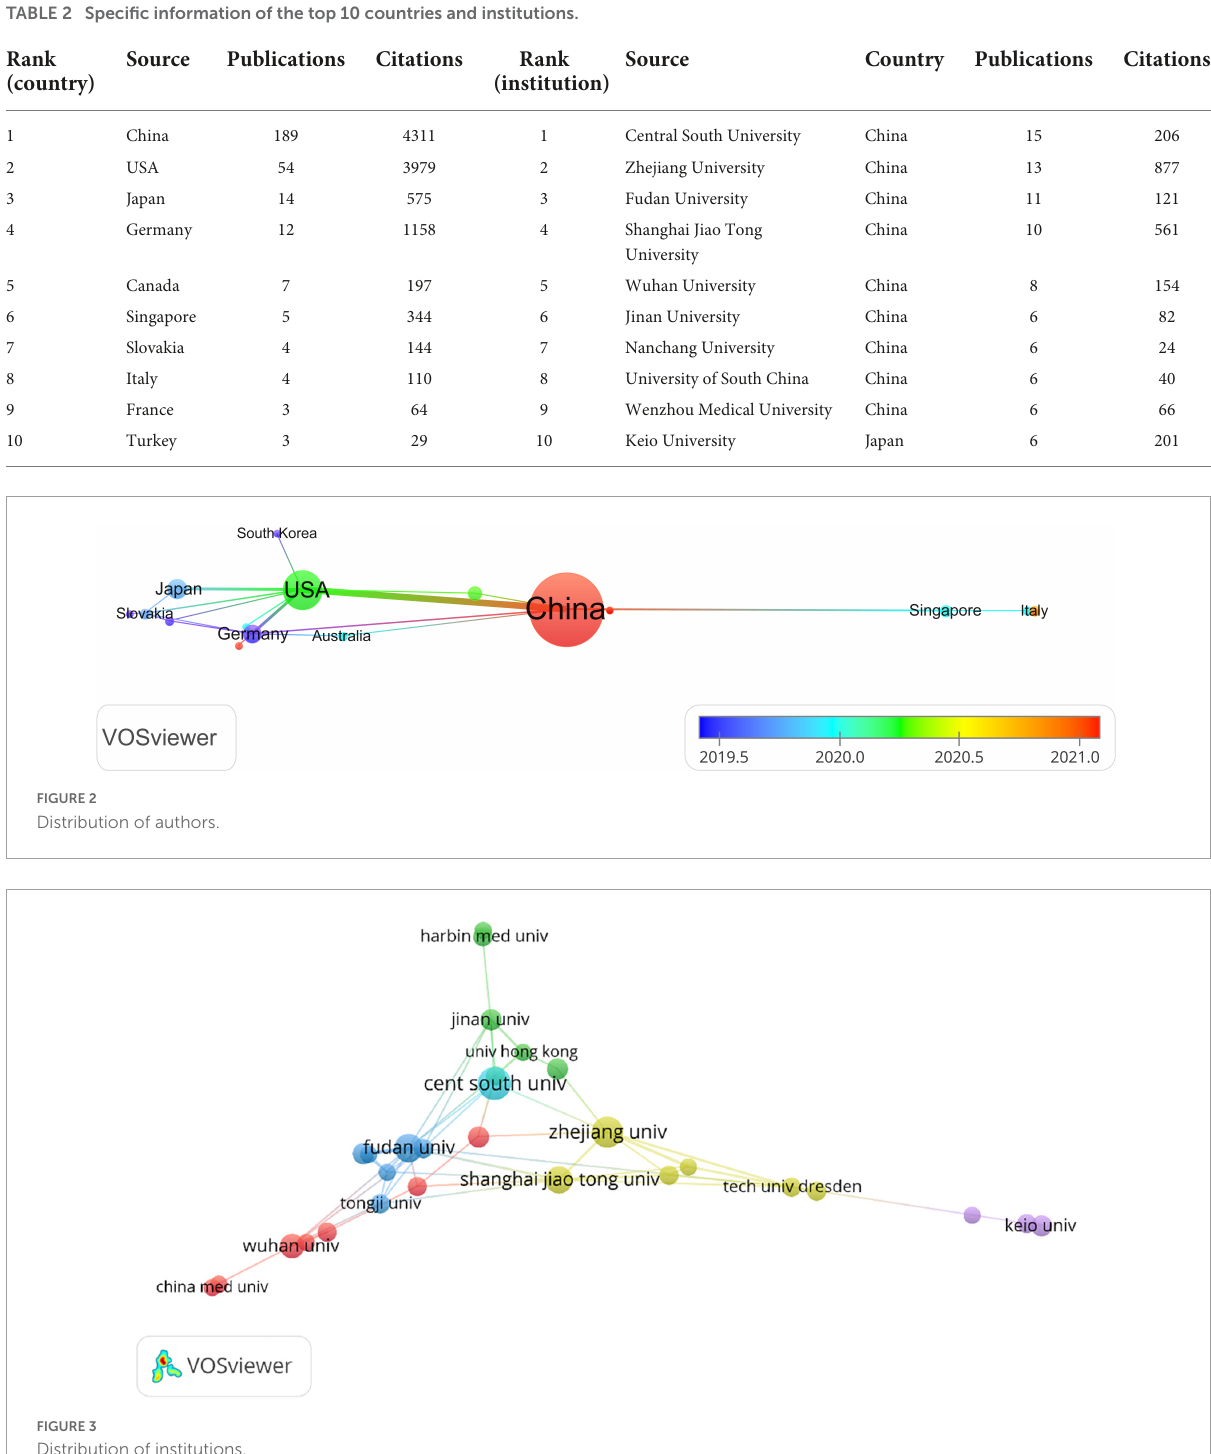
FIGURE3 Distribution of